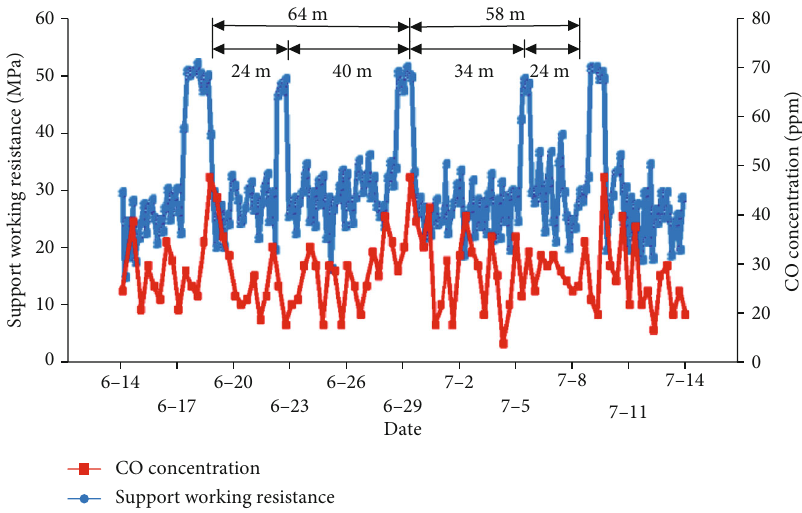
Figure 3: CO concentration and mining pressure curve in the upper corner of the panel.